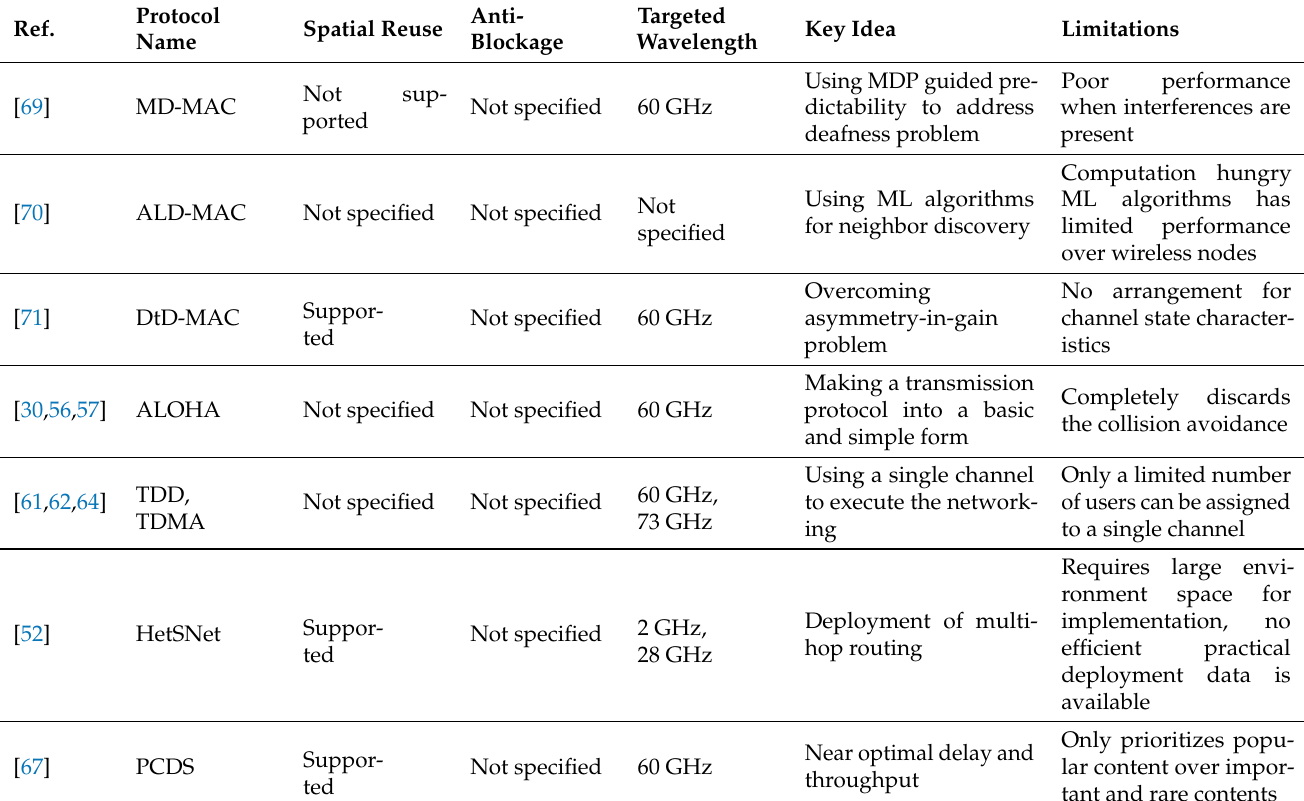
Table 5. Comparative analysis of distributed MAC protocols.